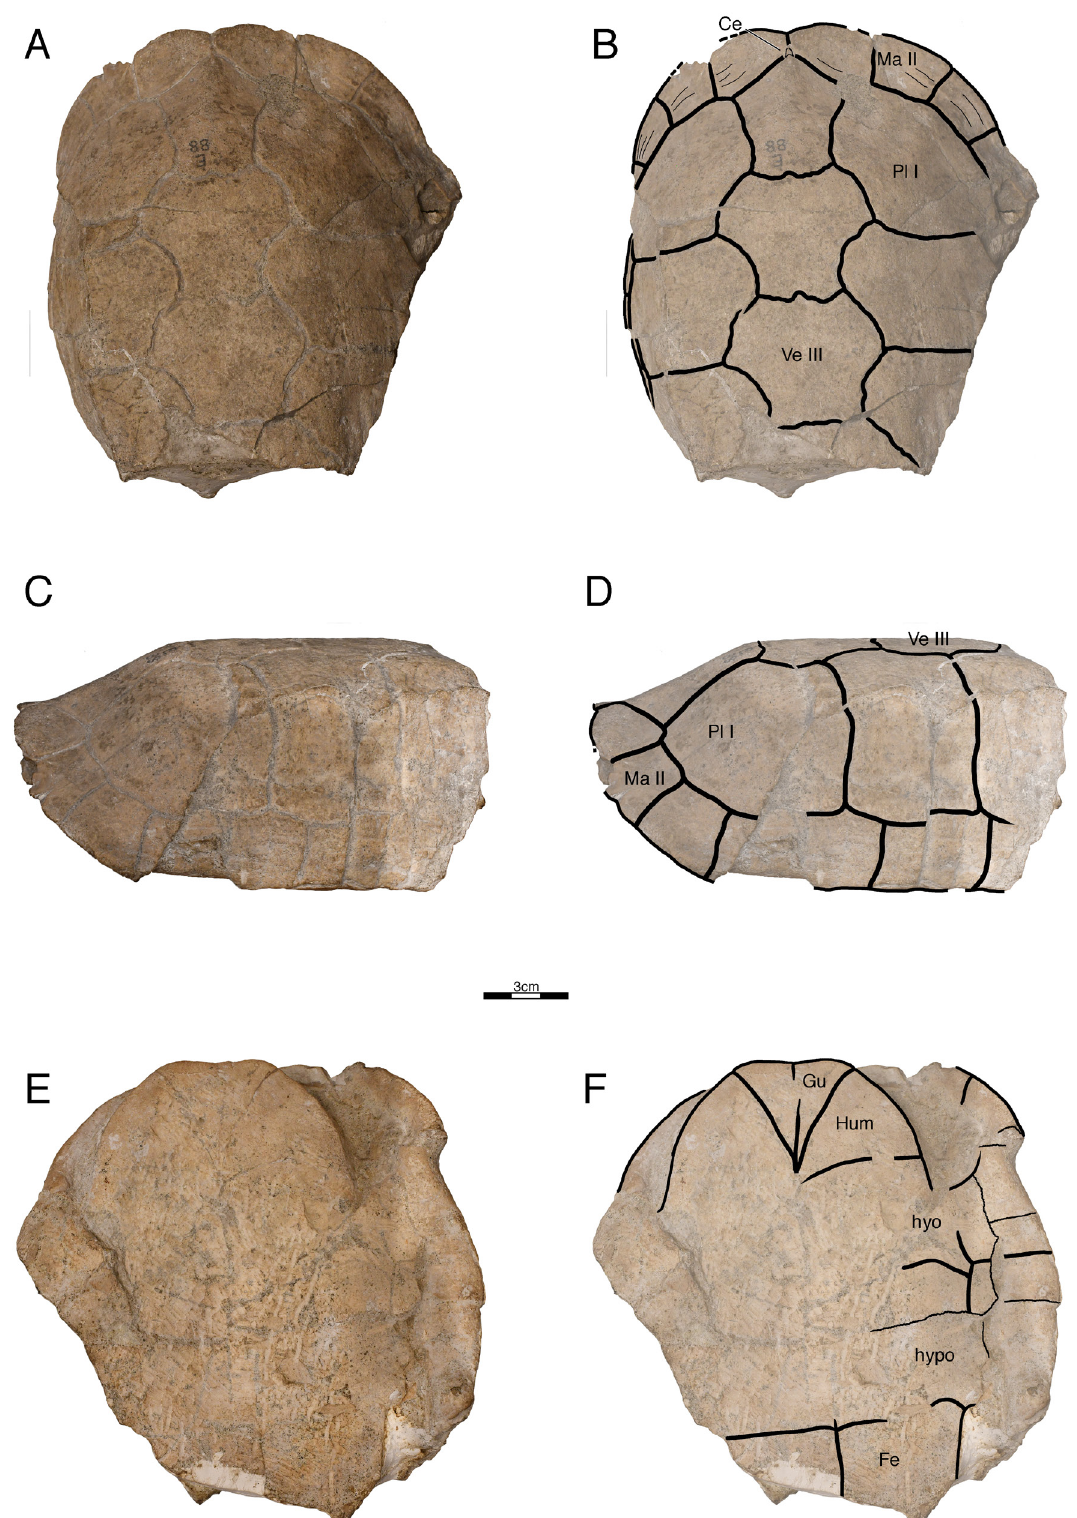
Fig. 27. IM E.88, holotype of Bellia sivalensis Theobald, 1877, here identified as Melanochelys sivalensis (Theobald, 1877) comb. nov. A . Photograph of carapace. B . Illustration of carapace. C . Photograph of carapace in lateral view. D . Illustration of carapace in lateral view. E . Photograph of plastron. F . Illustration of plastron. Scale bar: 3